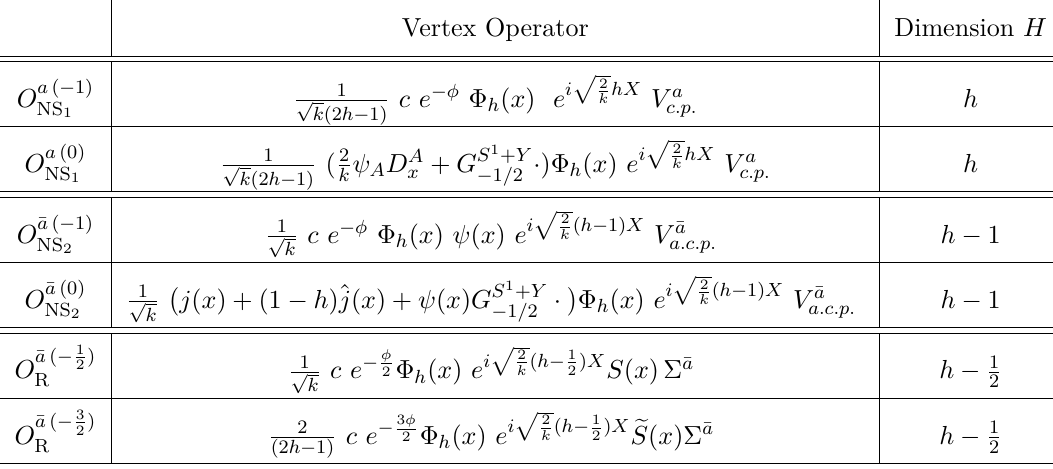
Table 1 . The world sheet vertex operators representing space-time chiral primaries and their space- time left-moving conformal dimension, in the subsector with spectral flow number equal to